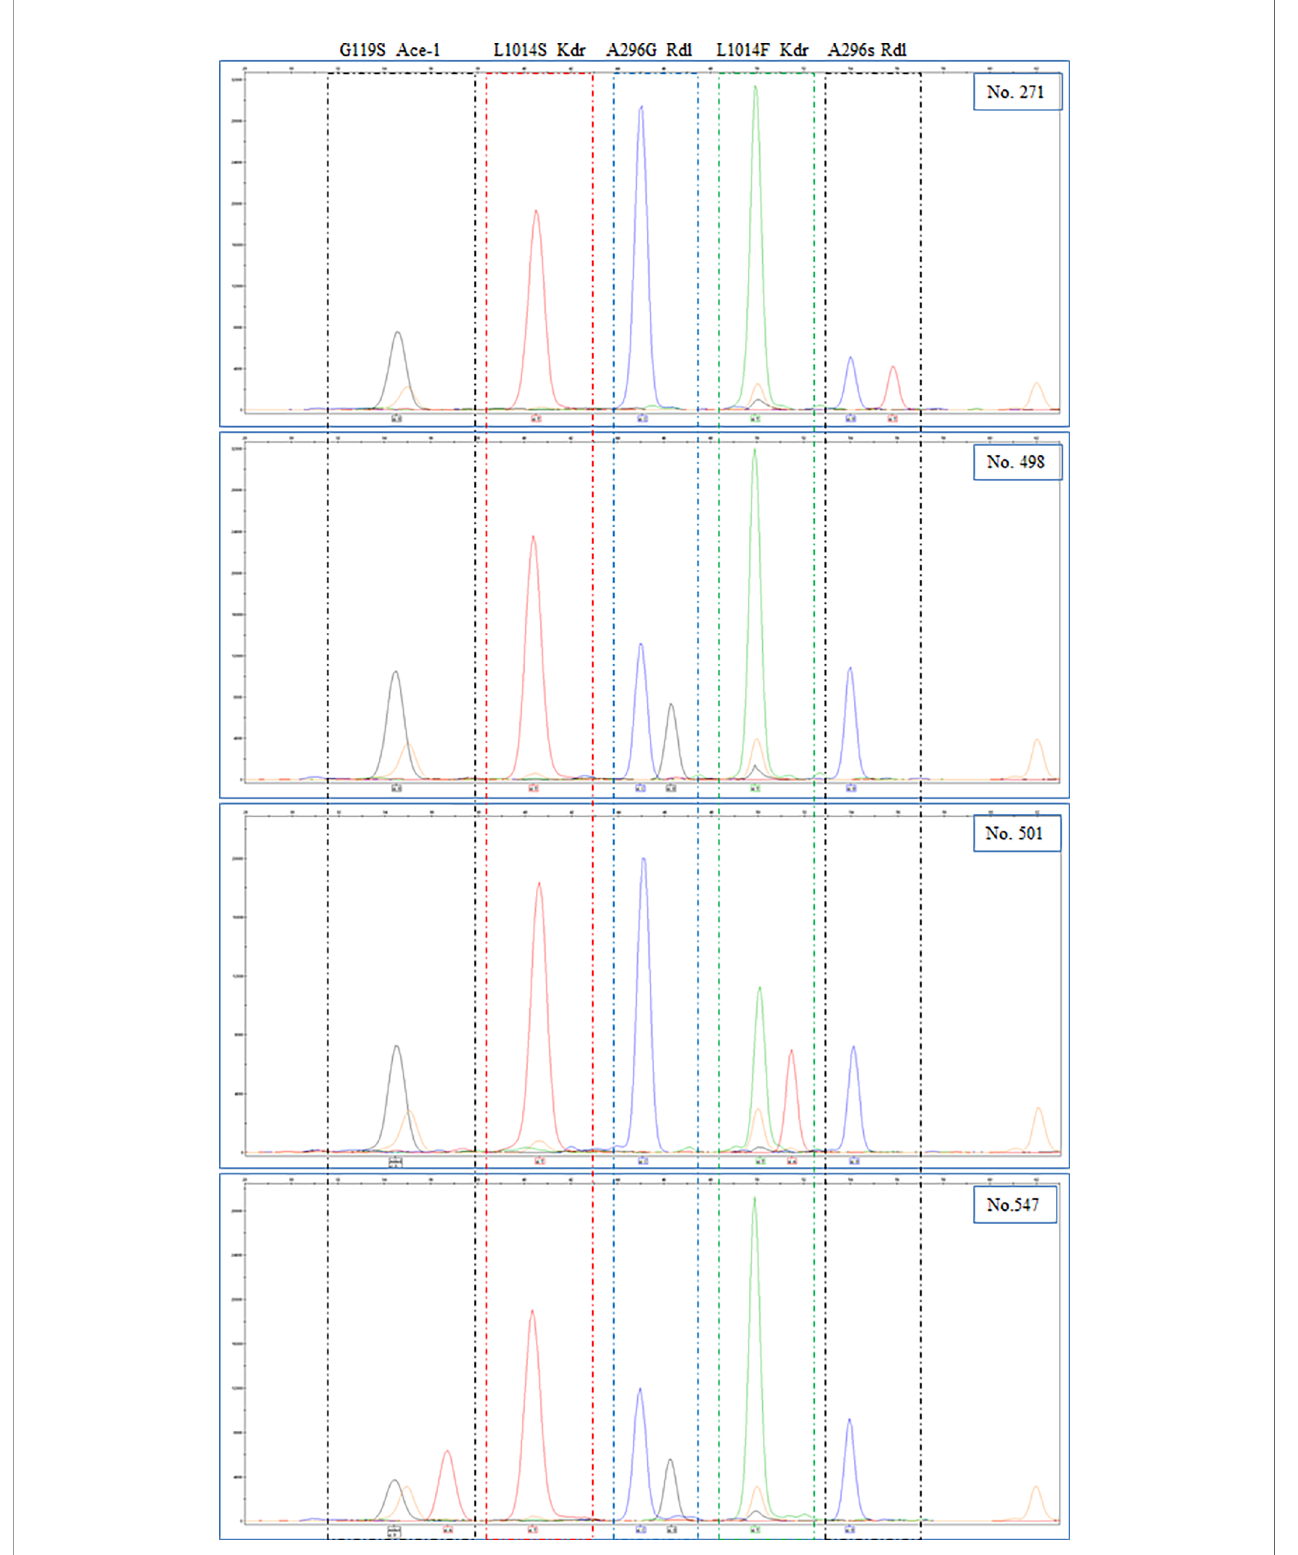
FIGURE 1 | Electropherograms of genscan analysis of the SNaPshot reaction and alleles were indicated at the bottom. (Blue peak: G; Black peak: C; Green peak: A; Red peak: T; Orange peak: size